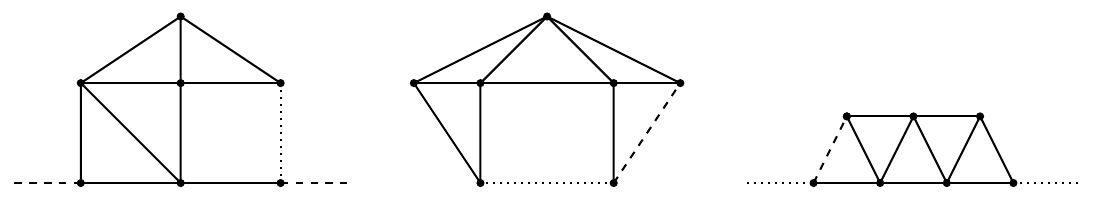
Figure 2 . Starting with the five-loop p-integral on the left and glueing the external lines (dashed), we obtain the six-loop vacuum diagram in the center. This diagram has 12 propagators and no numerator, leading to a vanishing superficial degree of divergence. Since there are no subdivergences, we can cut a different propagator (dotted) to produce a distinct five-loop p-integral with the same value in four